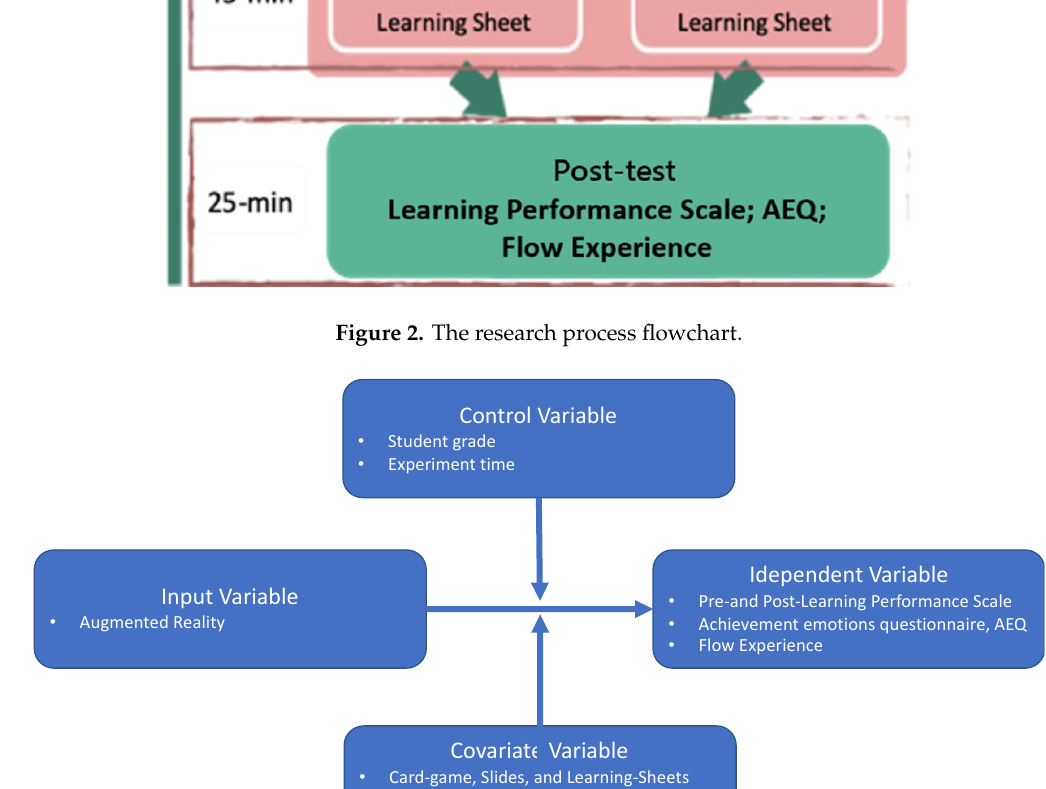
Figure 4. Experimental group playing scene.